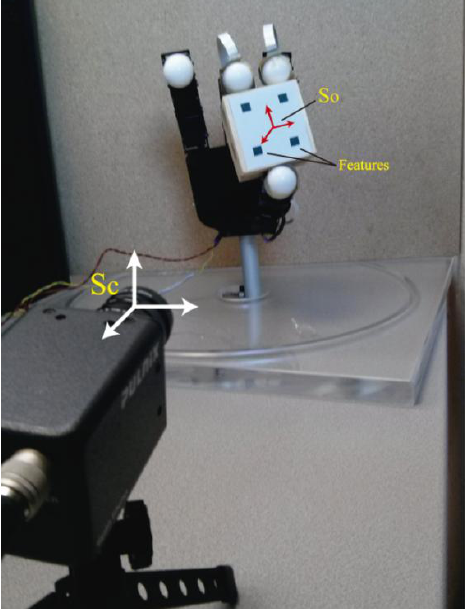
Figure 2. Experimental setup for dexterous manipulation (robotic hand, manipulated object, eye-to-hand camera and reference